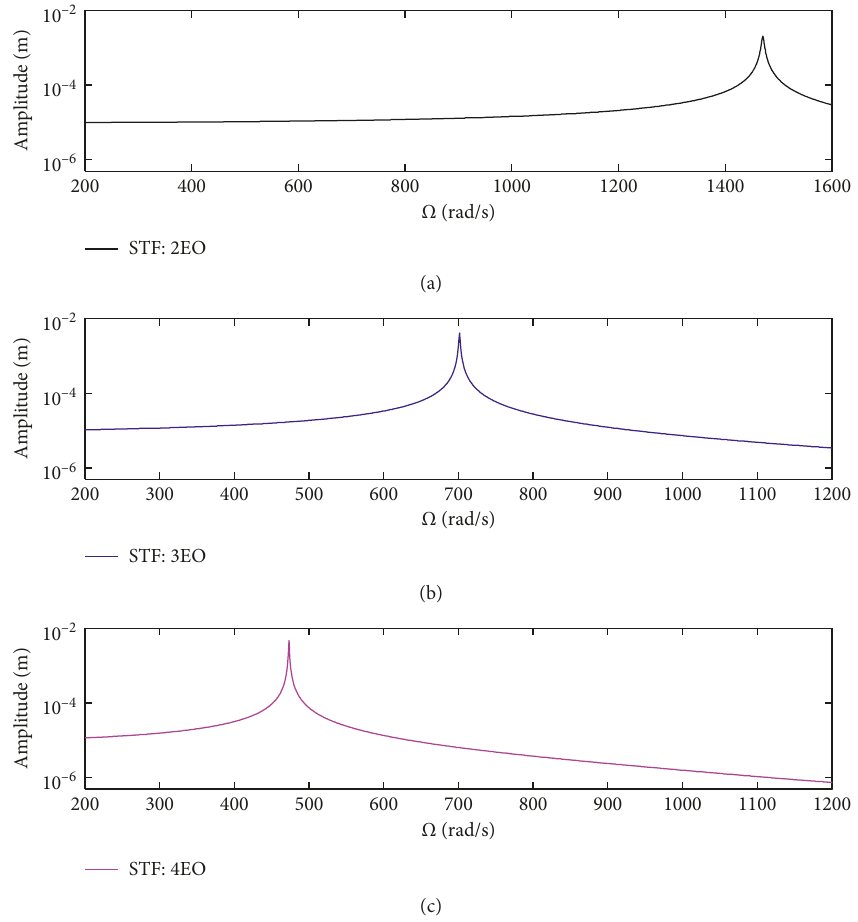
Figure 5: Forced response of STF case of tuned bladed disk versus rotating speed excited by backward traveling wave excitations of (a) 2EO, (b) 3EO, and (c)